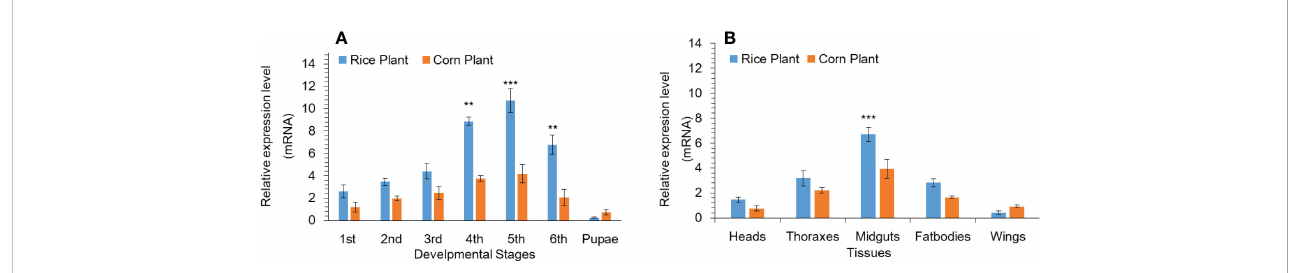
FIGURE 1 Developmental (A) and tissue-speci fi c (B) expression pattern of Spodoptera frugiperda CYP302A1 after feeding on rice and corn plants. Real-time quantitative RT-qPCR analysis was used to determine relative transcript levels. Data shown are mean ± SE. Treatments were compared using Student ’ s t test. ** and *** represent P < 0.01 and P < 0.00,